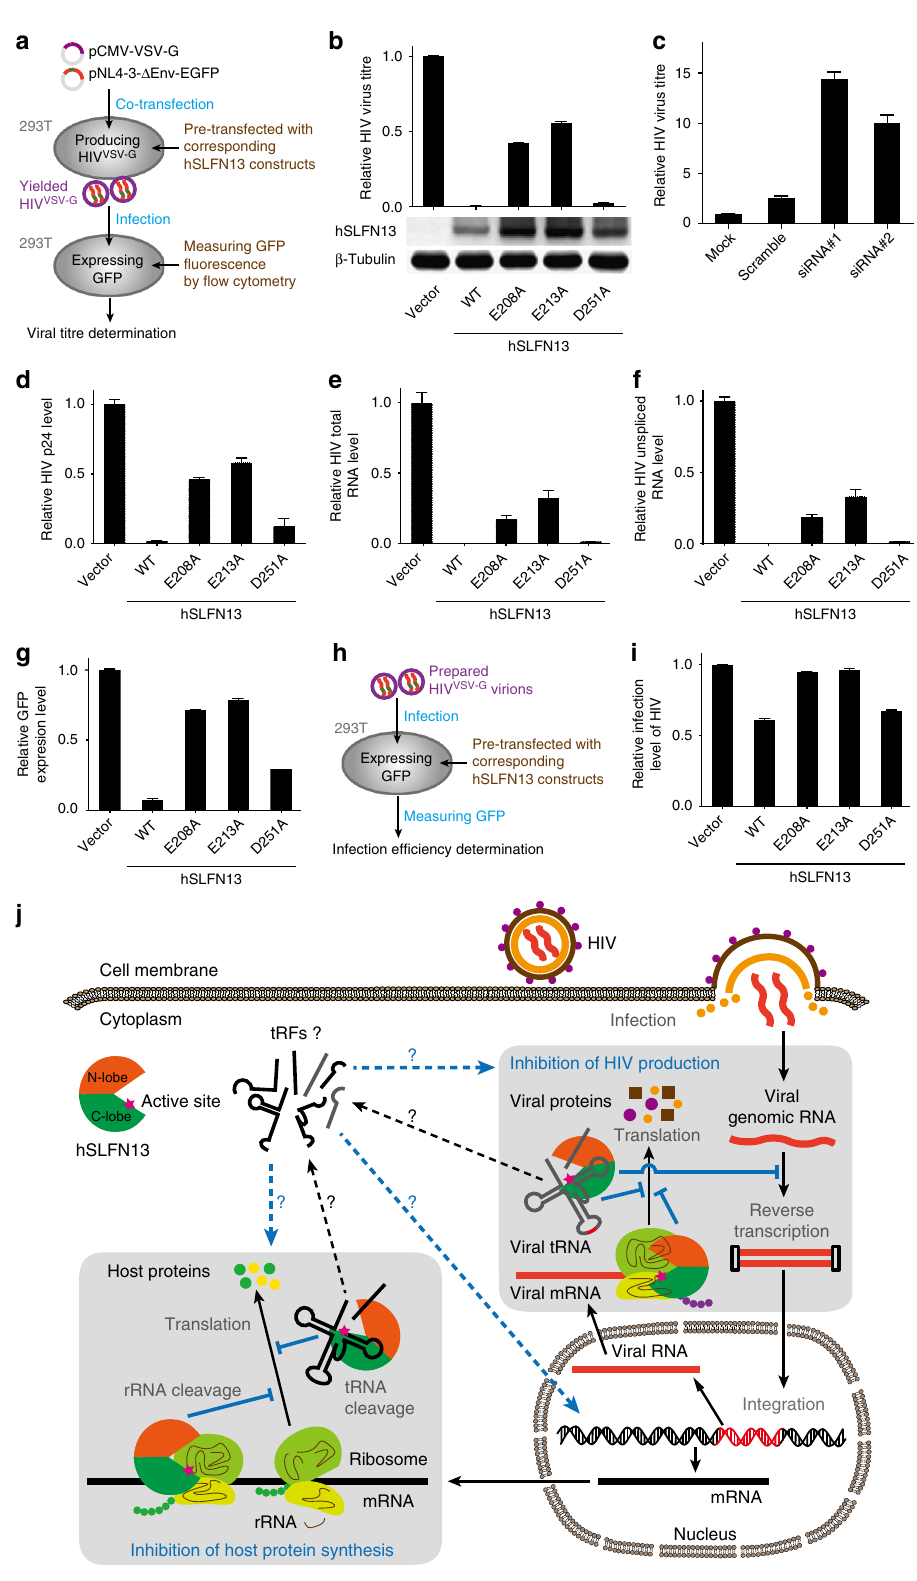
Fig. 6 hSLFN13 restricts HIV production. a The experimental process of titre assay for VSV-G pseudotyped HIV (HIV VSV-G ). b Viral production was assayed by titrated infection and the GFP level. Expression of hSLFN13 WT and mutants was con fi rmed by Western blot. Error bar indicates s.d. ( n = 3). c Knock-down of endogenous SLFN13 increased viral titre of 293 cells. d Viral particle content in supernatants was analysed by p24 ELISA. e , f Extracellular vRNA concentration was determined by qPCR for total vRNA ( e ) and unspliced vRNA ( f ). g hSLFN13 suppressed GFP production from the viral plasmids. h The experimental process of the viral infection assay. i Examination for the infection ef fi ciency of HIV VSV-G in cells pre-transfected with hSLFN13 WT or mutants. j Proposed protein synthesis inhibition and anti-HIV mechanism of